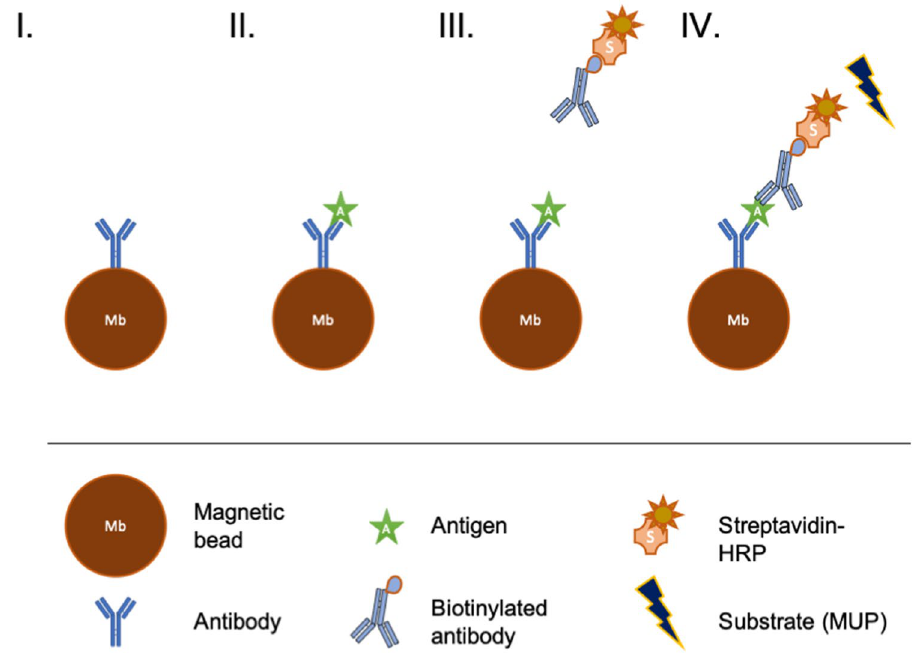
Figure 1. Schematics of the sequential protocol of immuno-capture of the antigen IL-6. (I) the beads coated with the capture antibody are inserted inside the fluidized bed (II) the antigen is flowed through the microfluidic chip and captured on the bead surface (III) the biotinylated antibody is mixed off-chip with the enzyme-streptavidin complex then flowed through the chip and attached to the antigen (IV) the antibody- enzyme detection complex is flowed through the fluidized bed and captured on the beads. Finally, the detection is performed using an enzymatic substrate